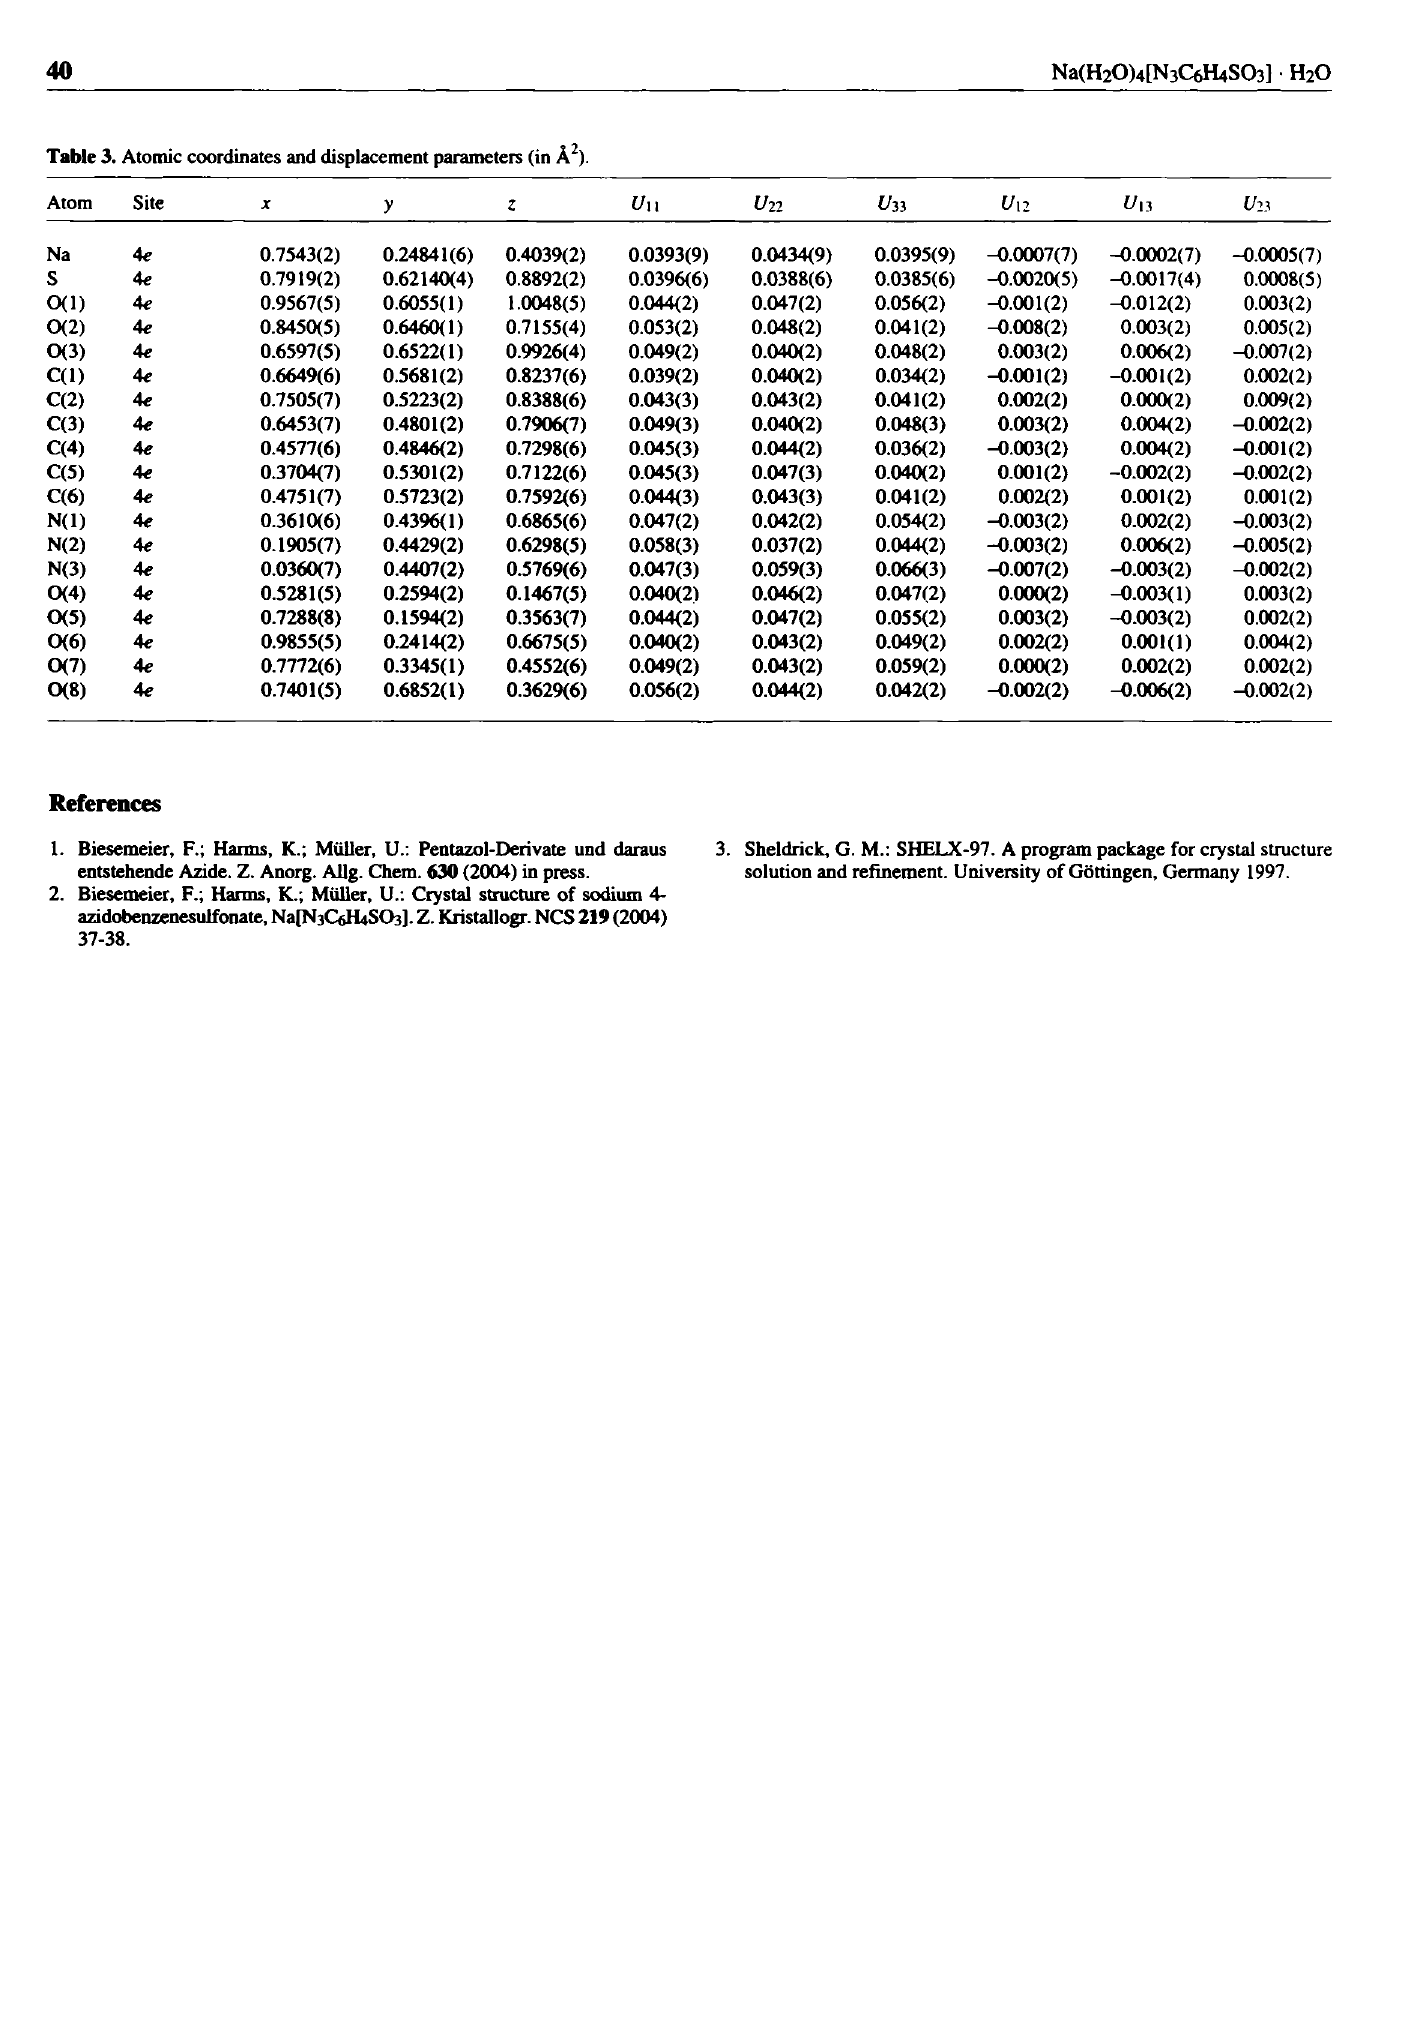
Table 3. Atomic coordinates and displacement parameters (in Ä 2